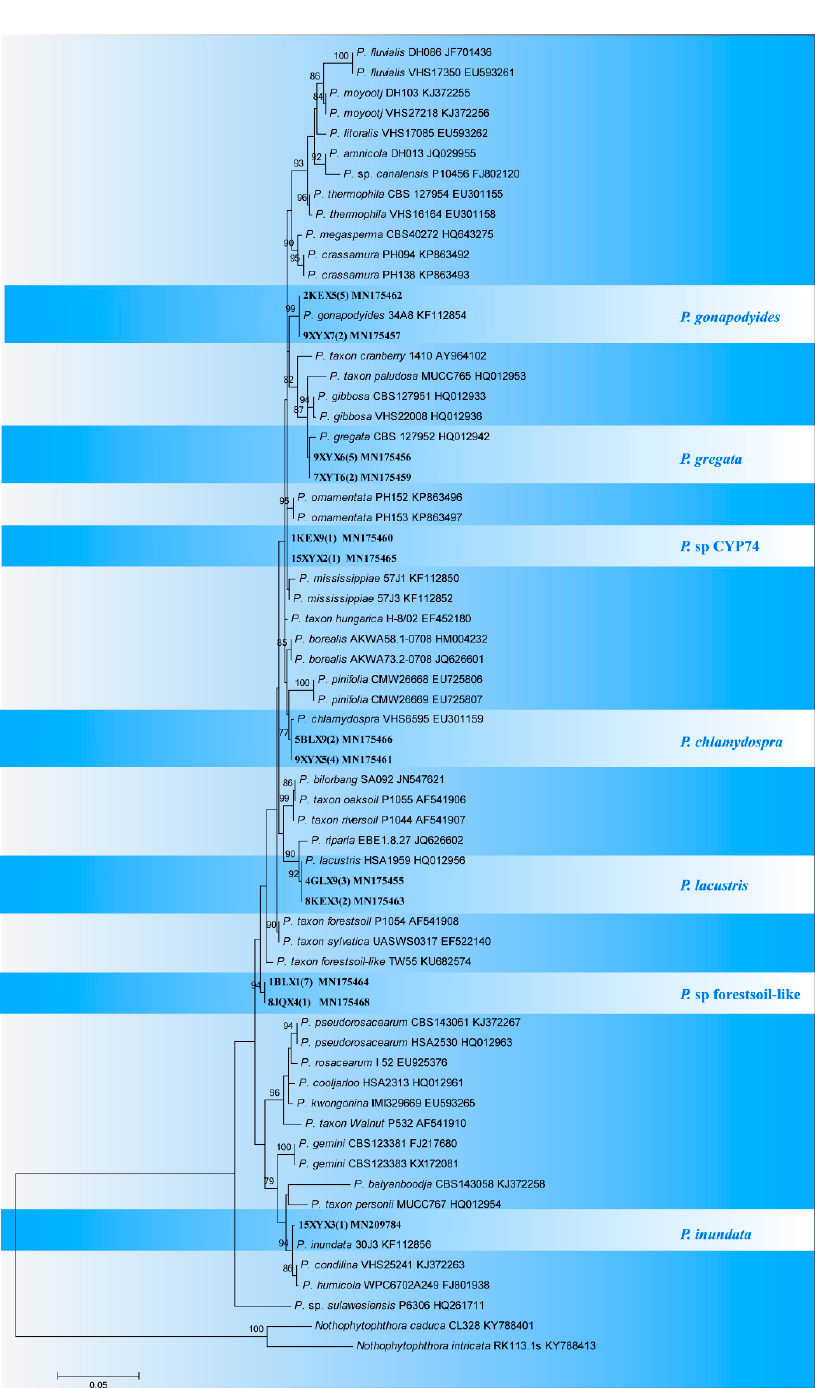
Figure 3. A phylogram based on ITS sequence data indicating the placement of clade 6 and the undescribed Phytophthora taxa recovered in this study. The topological structures of Bayes and Maximum likelihood (ML) trees are the same. Bootstrap support is given above the line. Numbers above the branches represent the bootstrap support based on the maximum likelihood analysis.